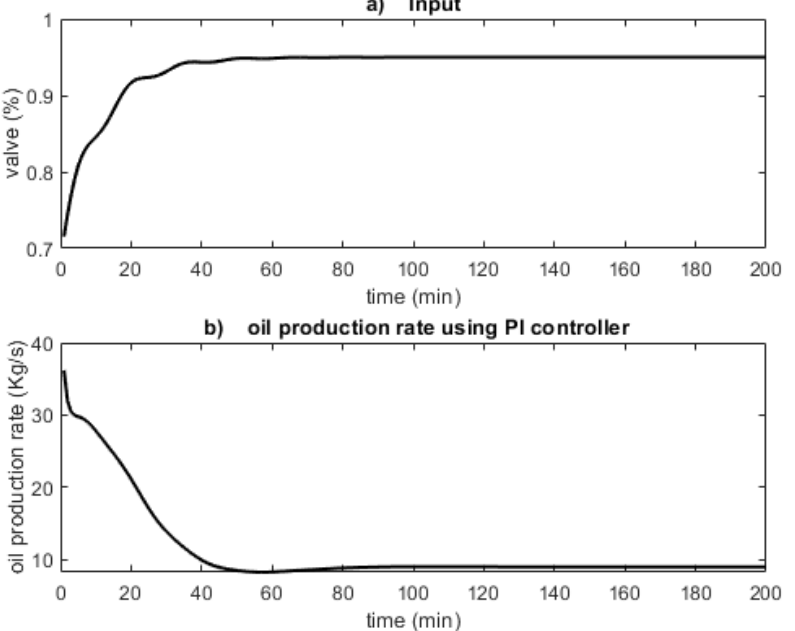
Figure 18. Input and output of the gas-lifted system using PI controller. The PI controller opens the valve gradually from the equilibrium point to u = 0.95, which is in the unstable region, making the oil production steady at 9.03